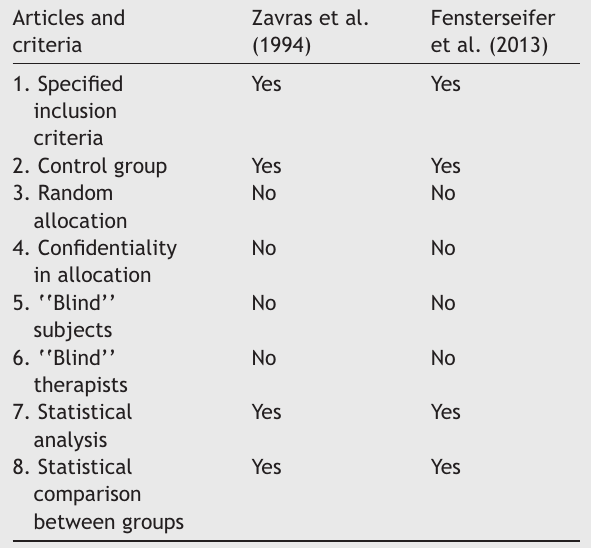
Methodological classification of selected